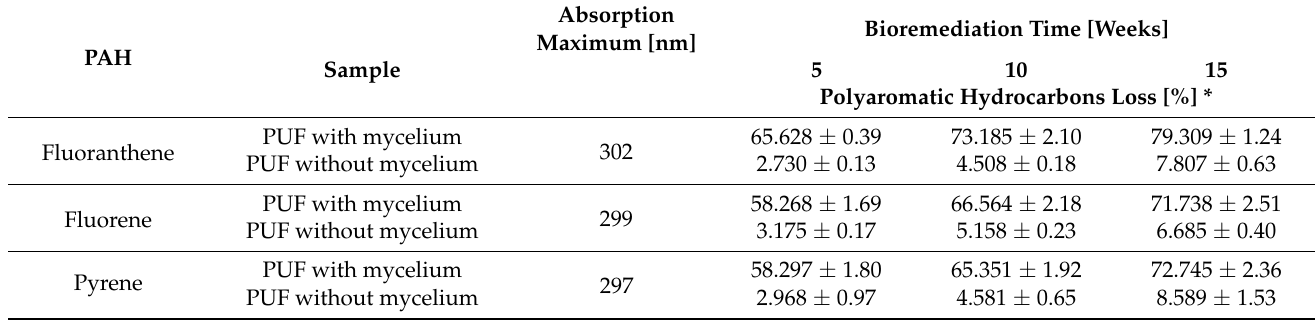
Table 2. Polyaromatic hydrocarbons loss on an example of fluoranthene, fluorene, and pyrene during bioremediation of soil contaminated with creosote oil by PUF-immobilized mycelium of B. adusta DSM